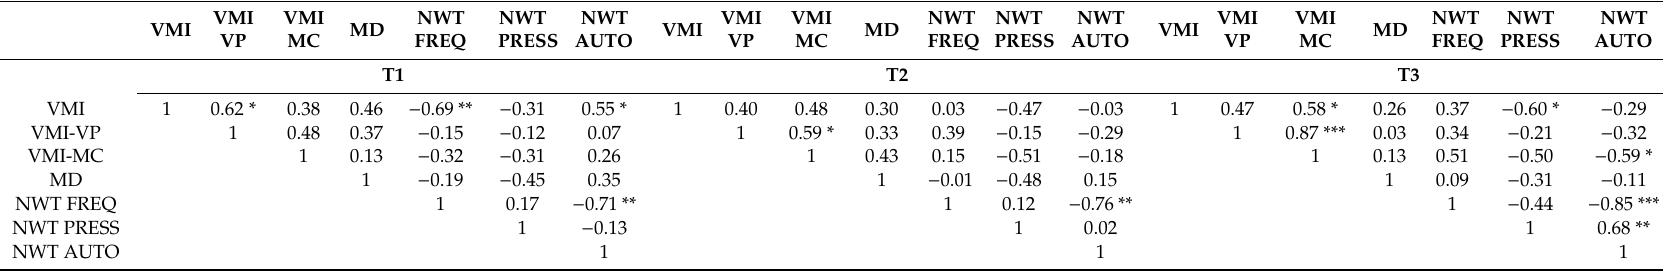
Table 2. Pearson’s correlations between Writing Test kinematic parameters and children’s visual-motor integration and manual dexterity scores at T1, T2,